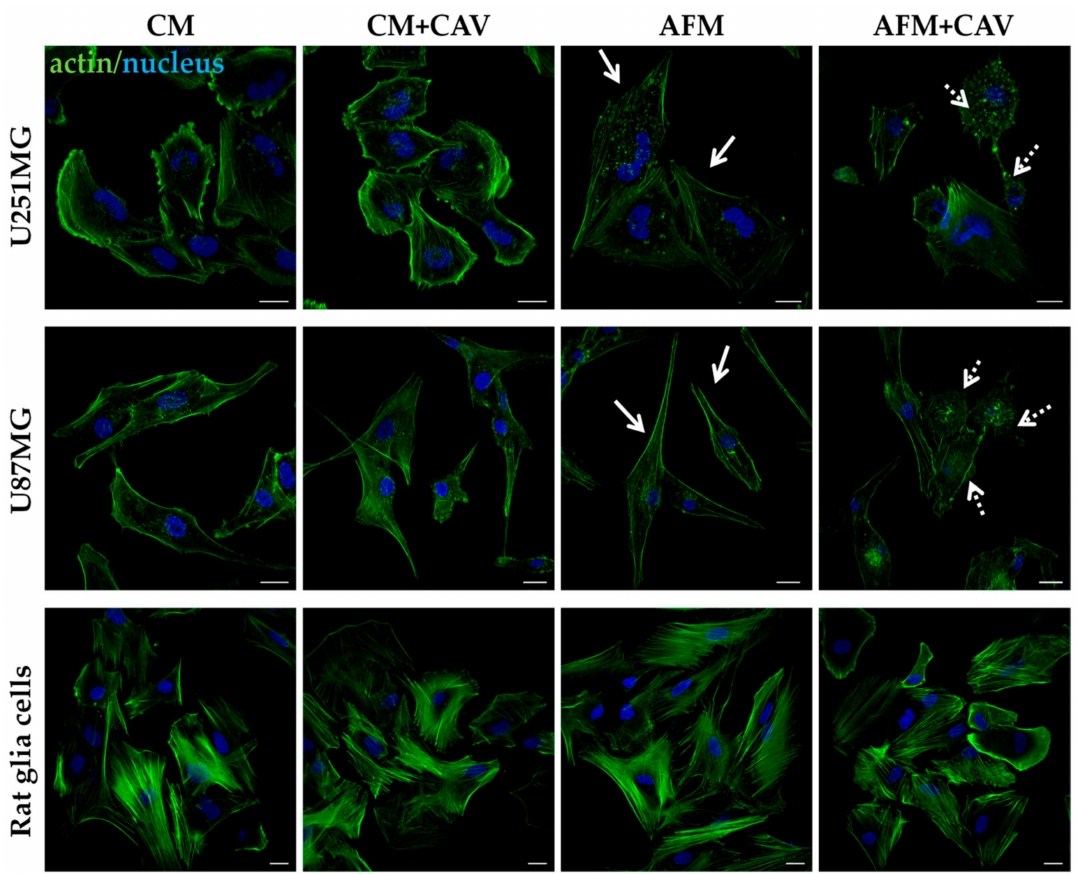
Figure 4. Organization of the actin cytoskeleton, probed with Alexa Fluor 488-conjugated phalloidin, of U251MG and U87MG human glioblastoma cells as well as normal rat glial cells. Cells were cultured for 48 h under experimental conditions with or without 50 µ M canavanine. Untreated cells (CM) served as a control. Nuclei were labeled with DAPI. Solid arrows indicate altered leading-edge morphology in cancer cells starved for arginine, and dotted arrows indicate actin-rich aggregates and blebs elicited by canavanine. Bars, 20 µ